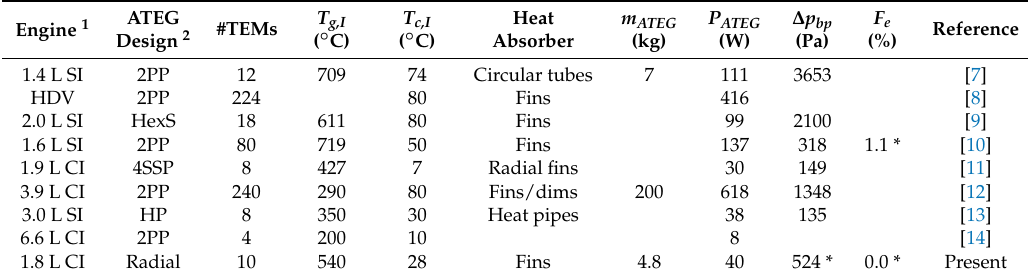
Table 1. Exhaust gas temperature at automotive thermoelectric generators (ATEG) inlet T g,i ,